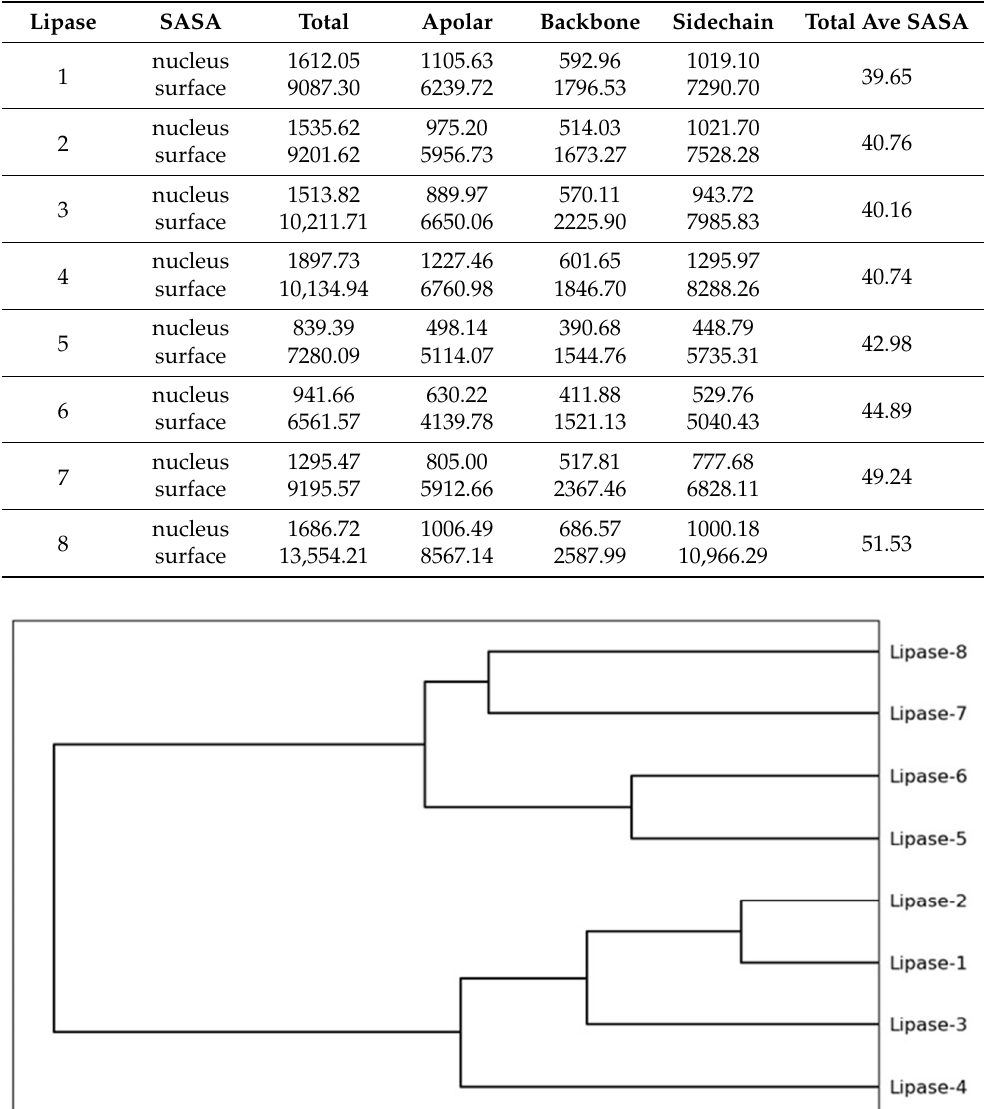
Table 6. Nucleus and Surface solvent accessible surface area (SASA) and average of total solvent accessible area for two environments (nucleus and surface). The data presented in angstrom (Å 2 ).